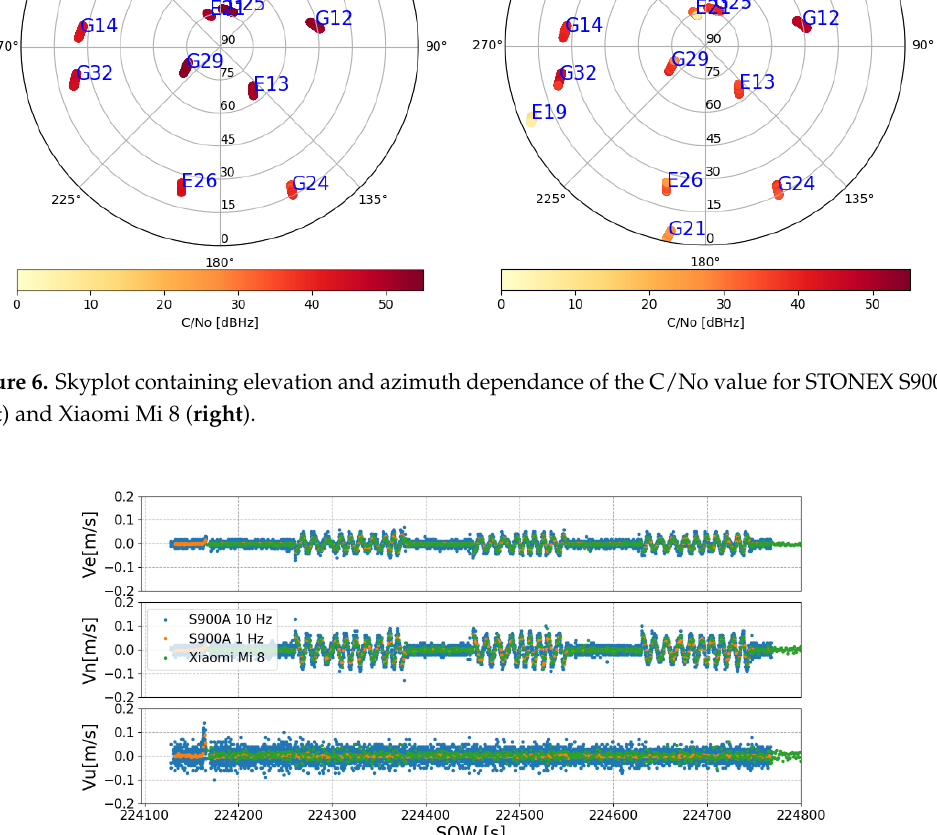
Figure 7. Time variation of 3D velocity in a local reference frame (East-North-Up)) obtained during the dynamic test. The plot shows variometric solutions for 10 Hz (blue) and 1 Hz (orange) measurements from STONEX S900A and 1 Hz (green) measurements from the Xiaomi Mi 8. SOW: second of the